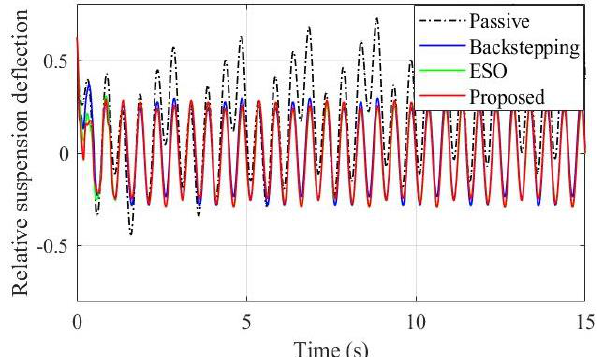
Figure 5. Simulation result of sprung mass acceleration.